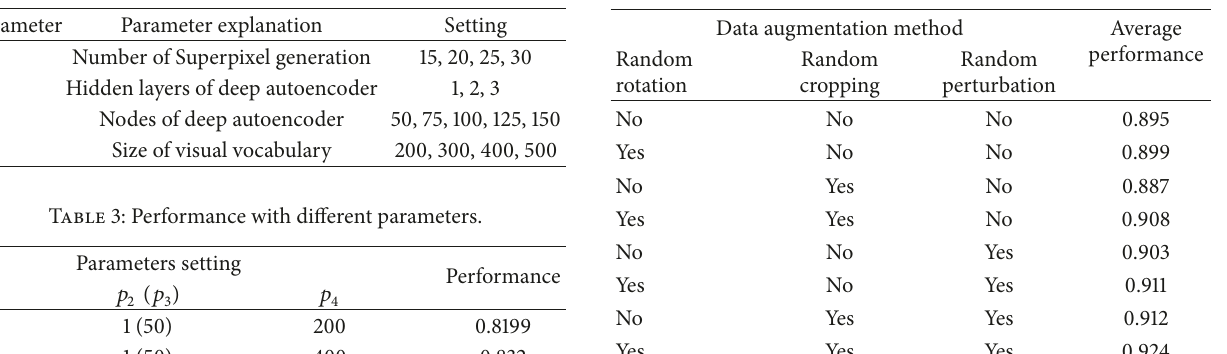
Table 2: Parameter setting.